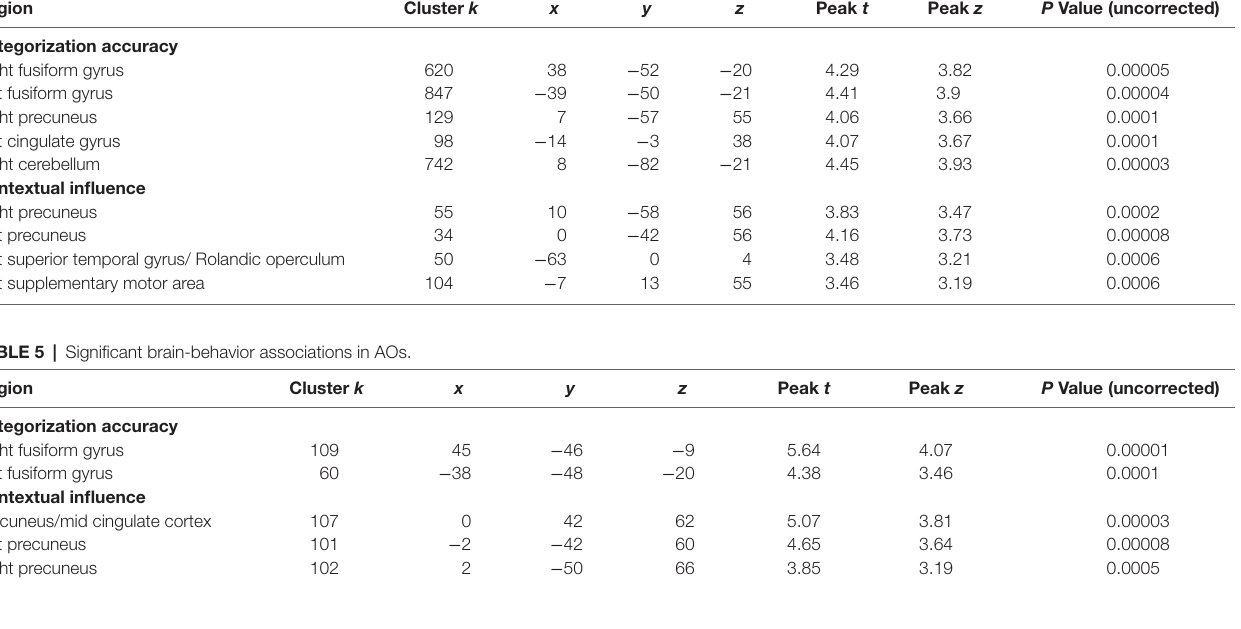
TABLE 4 | Significant brain-behavior associations for both groups together. Region